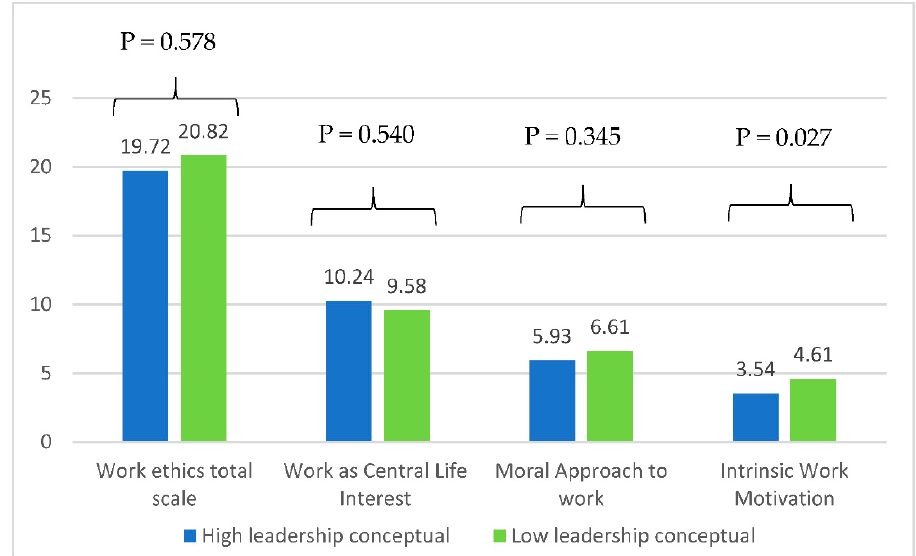
Figure 3. Mean values of the work ethics scale according to high/low conceptual leadership skills adjusted for age, gender, education level, and years of experience.